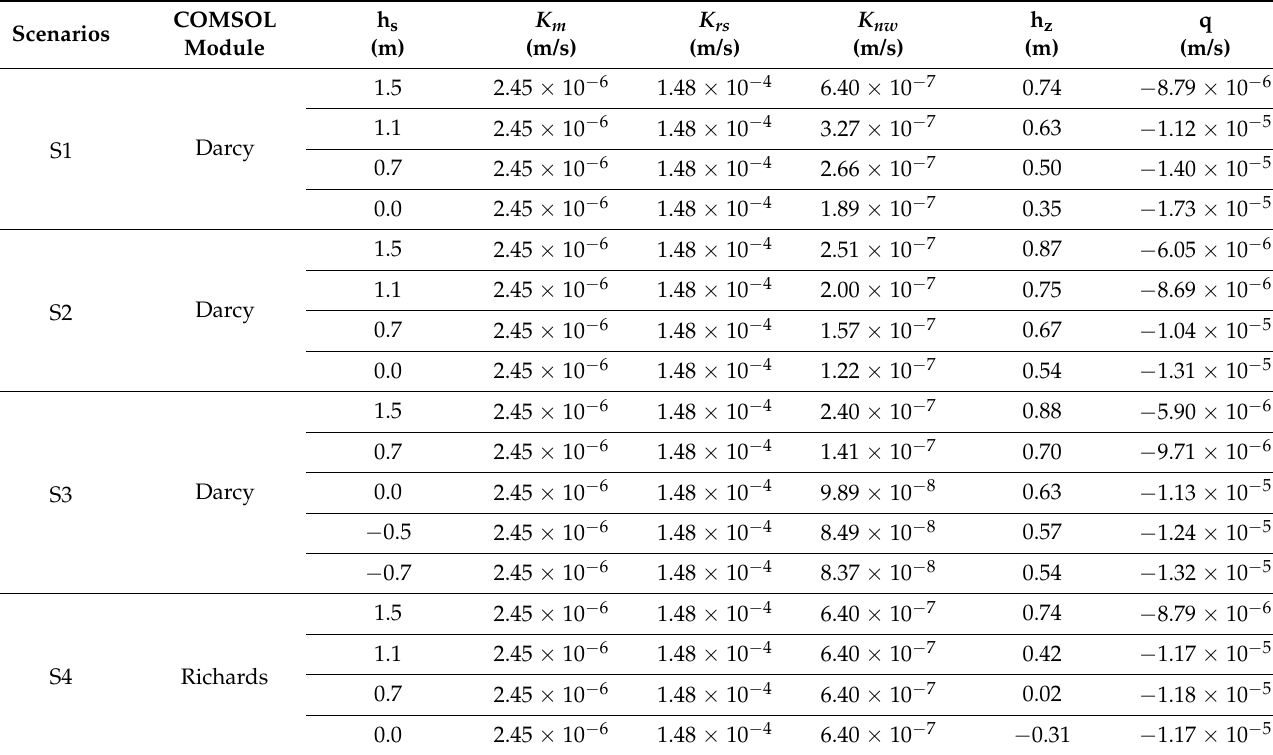
Table 2. Simulation results of the pore water pressure head at the location of the tensiometer (h z ) and the infiltration flux (q ) in each simulation